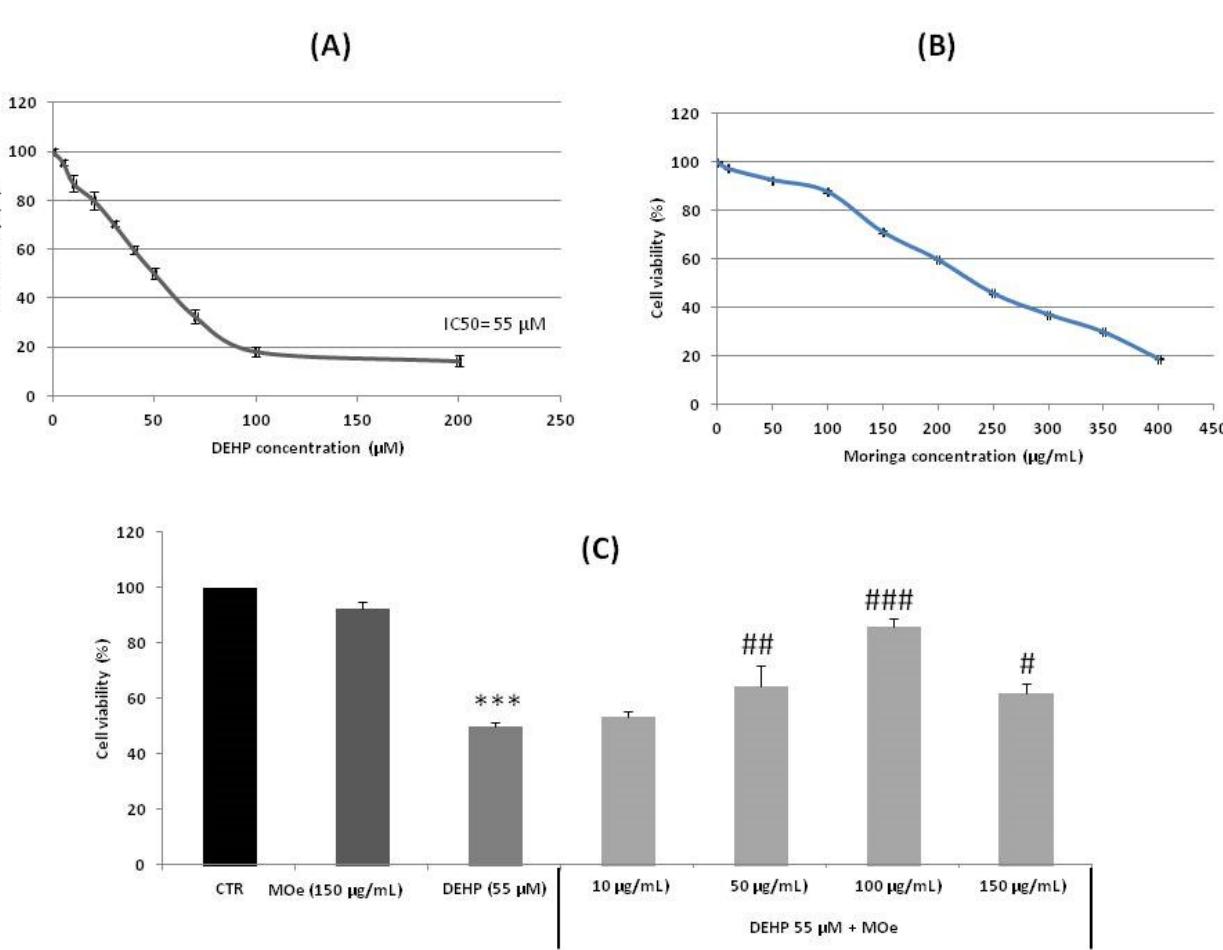
Figure 3. ( A , B ) Cytotoxic effect of di-(2-ethylhexyl) phthalate (DEHP) and Moringa oleifera extract (MOe) on SH-SY5Y cells. Cells were treated with DEHP or MOe at the indicated concentrations for 24 h. Cell viability was determined using the MTT assay and expressed as percentages of viability. ( C ) MOe reduces DEHP-induced cytotoxicity in SH-SY5Y. Cells were pretreated for 2 h with MO (10, 50, 100, and 150 µ g/mL) before DEHP treatment for 24 h (55 µ M). Data are expressed as the mean ± standard deviation (SD) of three independent experiments. *** p < 0.001 vs. control, # p < 0.05, ## p < 0.01, and ### p < 0.001 vs. DEHP alone.